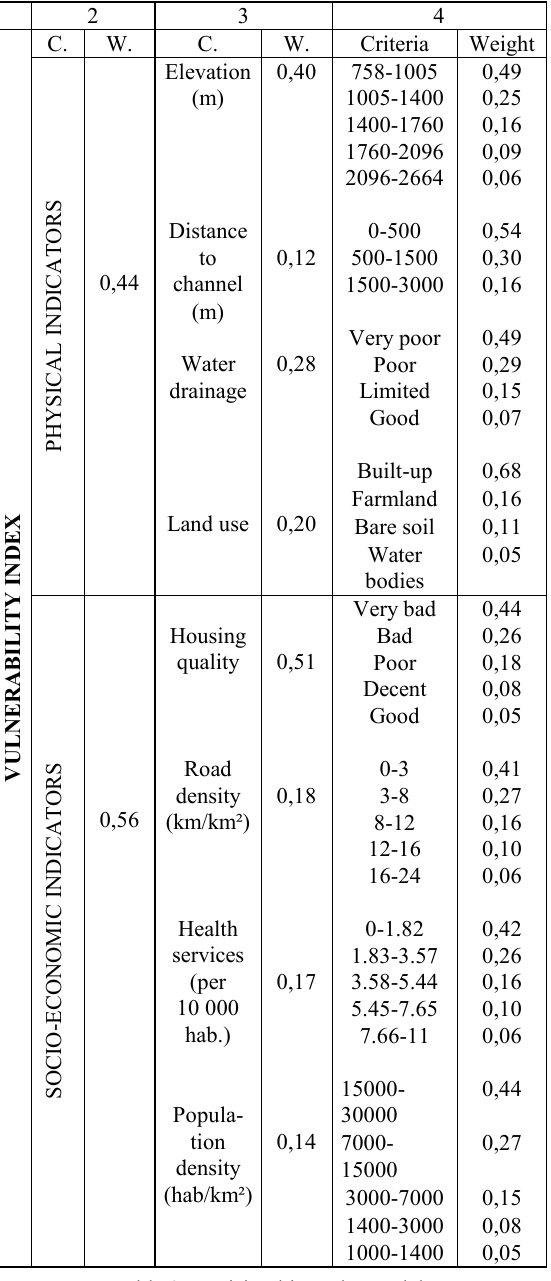
Table 3. Decision hierarchy